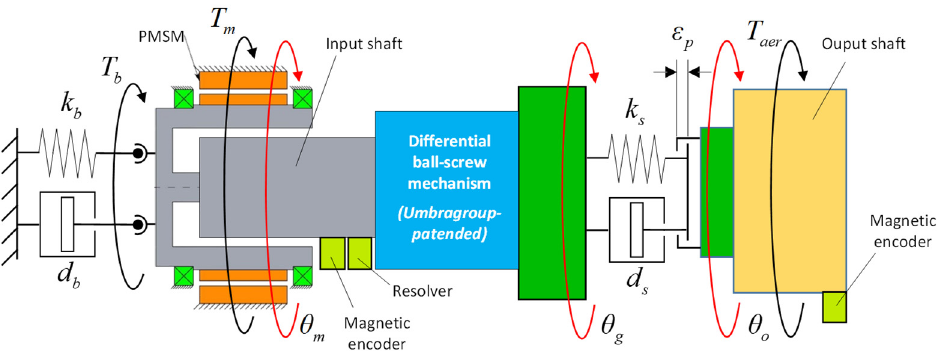
Figure 6. Schematics of the FLA electro-mechanical section.